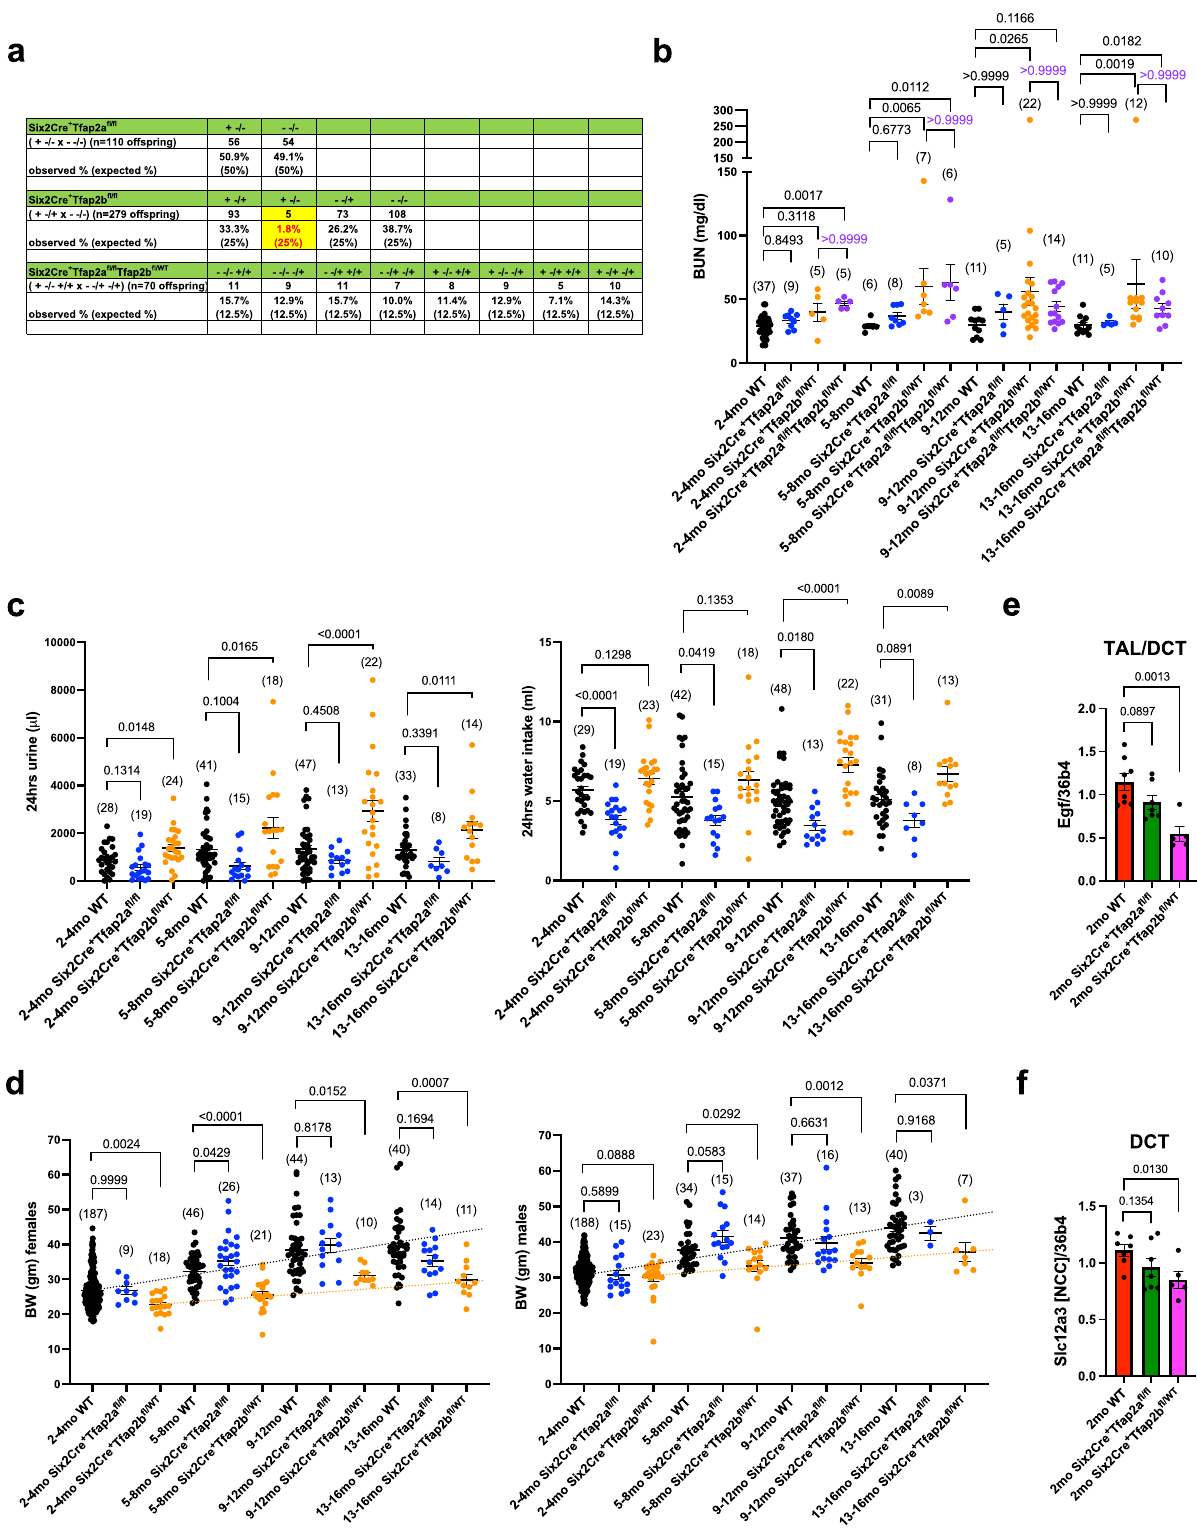
(Fig. 3a), and had normal BUN levels (Fig. 3b) and normal renal histology even at an advanced age (Supplementary Fig. S9a).